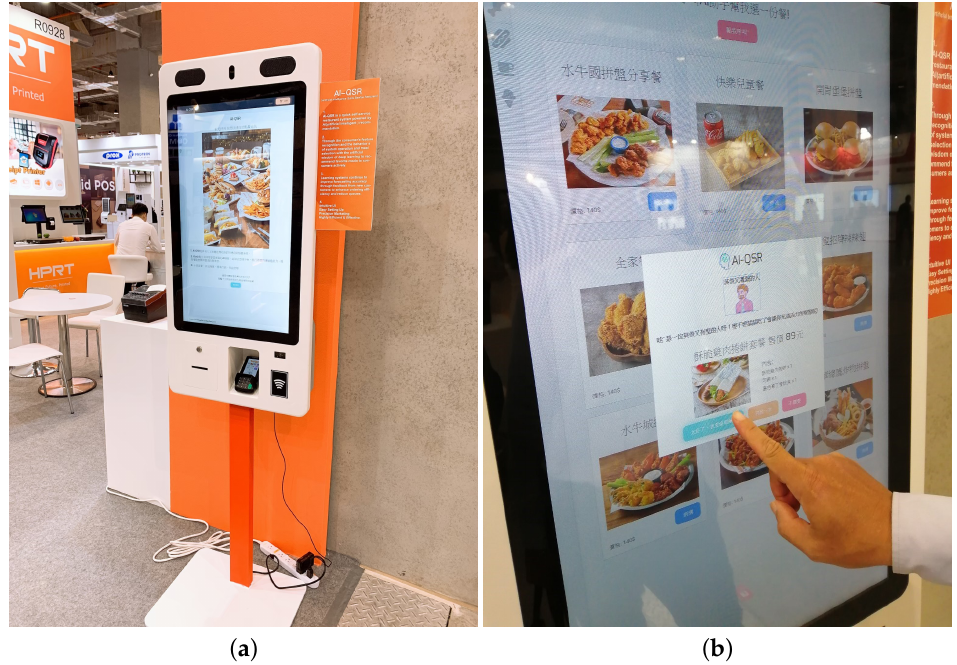
Figure 12. The AI-QSR user interface: ( a ) The AI-QSR KIOSK system. ( b ) The using of the AI-QSR KIOSK